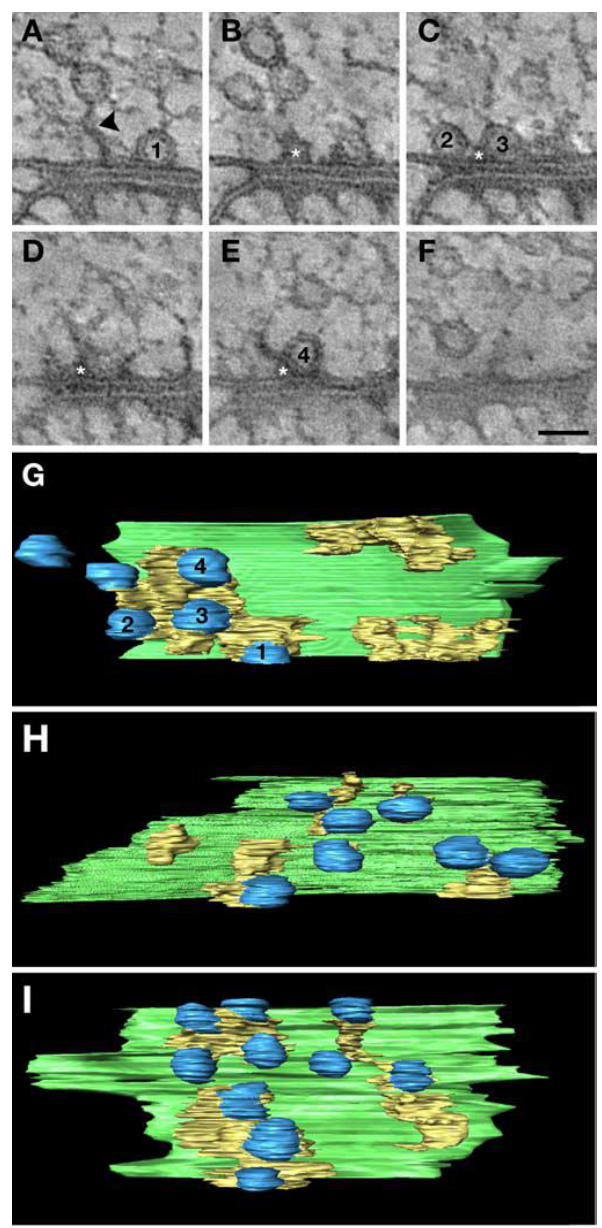
FIGURE 2 . The three-dimensional (3D) architecture of the presynaptic cytomatrix. Association of docked SVs with presynaptic densities revealed by electron tomography. (A–F) Six virtual sections from a tomogram. The sections are separated by ~19 nm in the z -axis. The docked SVs (numbered 1–4) are apposed to a presynaptic electron-dense material (asterisk). A filament (arrowhead) emerging from the electron- dense material contacts an SV. (G–I) 3D reconstruction of the docked SVs (blue) and the presynaptic electron-dense material (yellow) in front of the postsynaptic density (green). G is the same synapse as in A–F. H and I are two other examples. Scale bars: A–F, 50 nm. Reprinted with permission from Siksou et al.[31]. Copyright 2007 the Society for